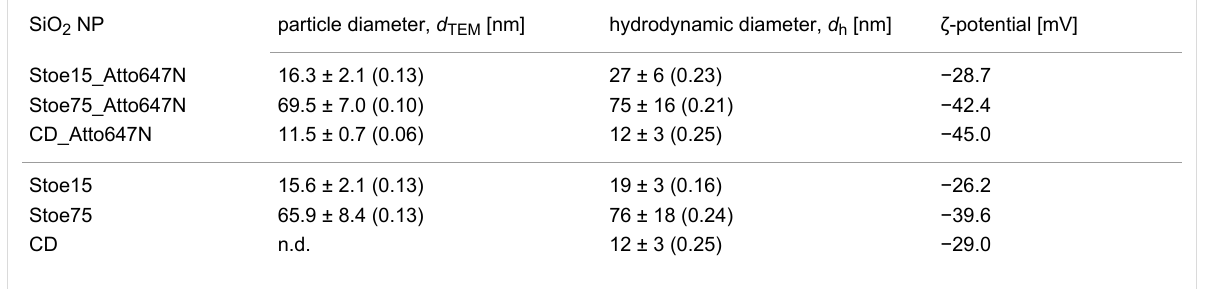
Table 2: Overview of the physical particle attributes of Atto647N-dyed silica nanoparticles, synthesised by the Stöber method or the C-dots method. Particle diameter and size distribution of the samples were characterised by TEM image analysis. The hydrodynamic diameter of the particles and their state of agglomeration in H 2 O was measured by DLS, whereas the particle charge was determined by ζ -potential measurements. The mean hydrodynamic diameter of the particles was determined, using the “volume distribution”. Numbers in brackets indicate the size dispersity p . SiO 2 NP